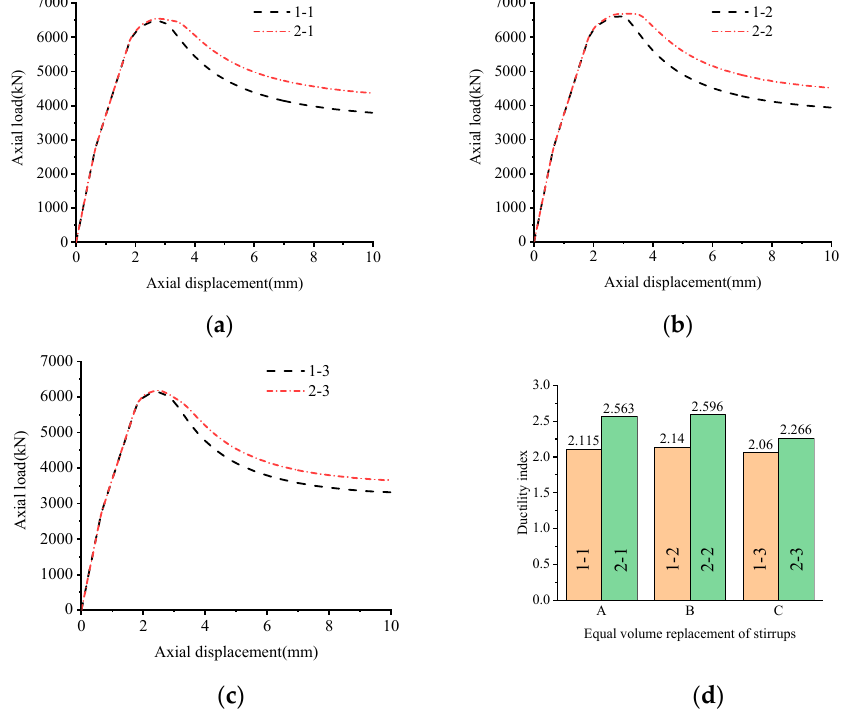
Figure 6. Effect of equal volume replacement of stirrup: ( a ) stirrup type A; ( b ) stirrup type B; ( c ) stirrup type c; ( d ) ductility index.